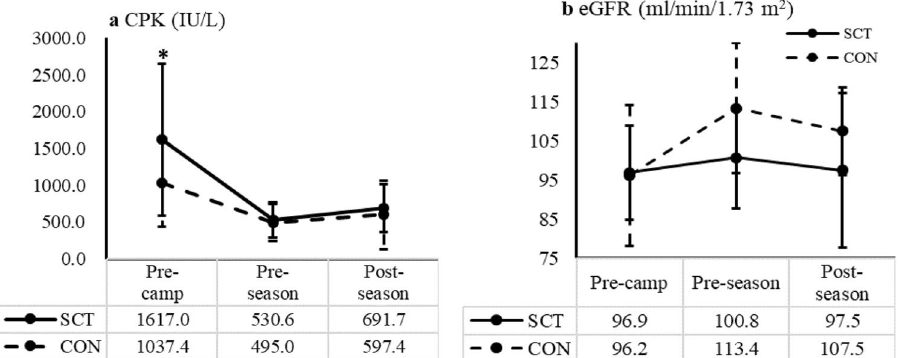
Figure 4. The CPK (creatine phosphokinase; a ) and eGFR (estimated glomerular filtration rate; b ) across the visits by groups (SCT and CON). Solid line indicates sickle cell trait players (SCT), and dash line indicates position-matched control group (CON). CPK levels were found significantly greater in SCT (1617.0 ± 1034.8 IU/L) at pre-camp compared to CON (1037.4 ± 602.8 IU/L; p = 0.04). The eGFR was lower in SCT at pre-season and post-season but not significant compared to CON (all p > 0.1). The eGFR was estimated by the equation from Shlipak et al. 15 .